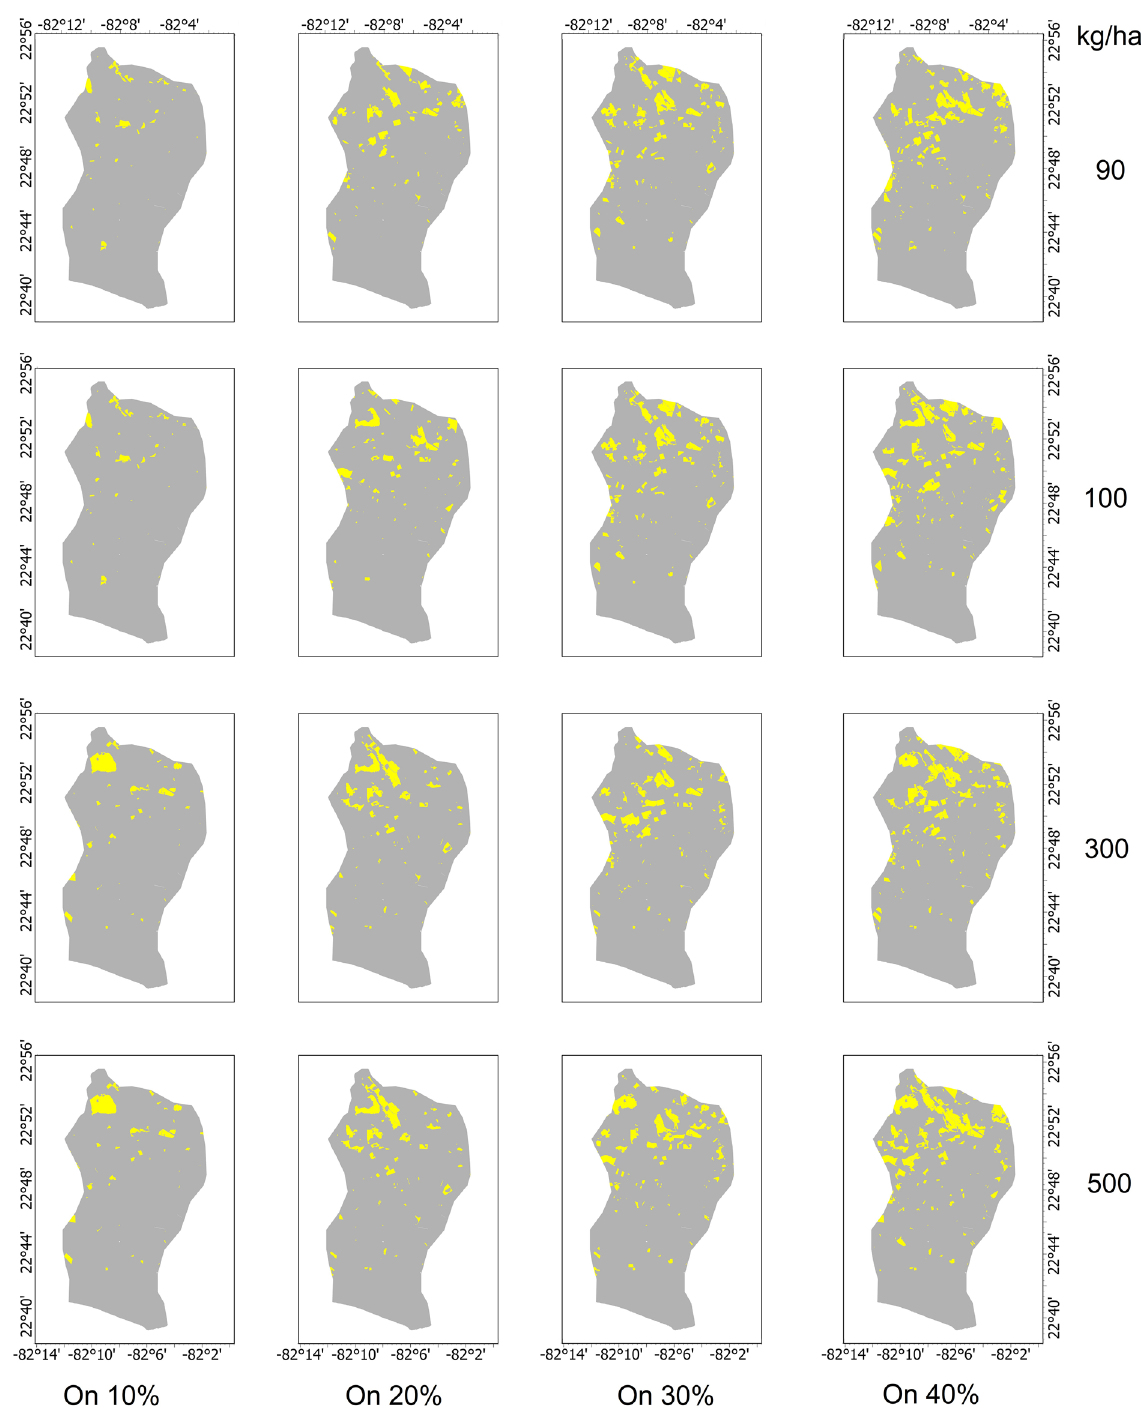
Fig. 12 Spatial distribution of the treatments in pastures with the highest export of nutrients to the Gulf of